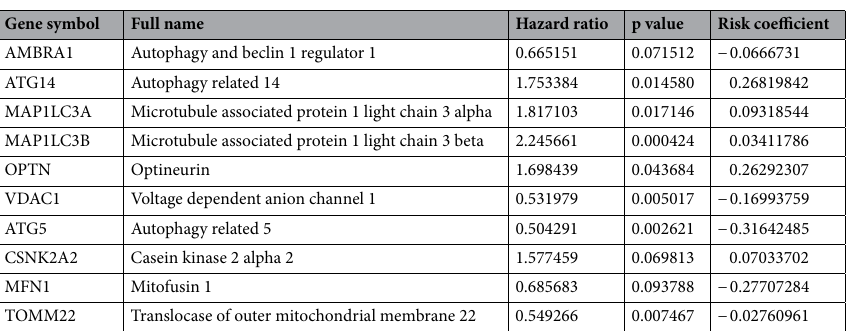
Table 1. General characteristics of genes in the prognostic gene